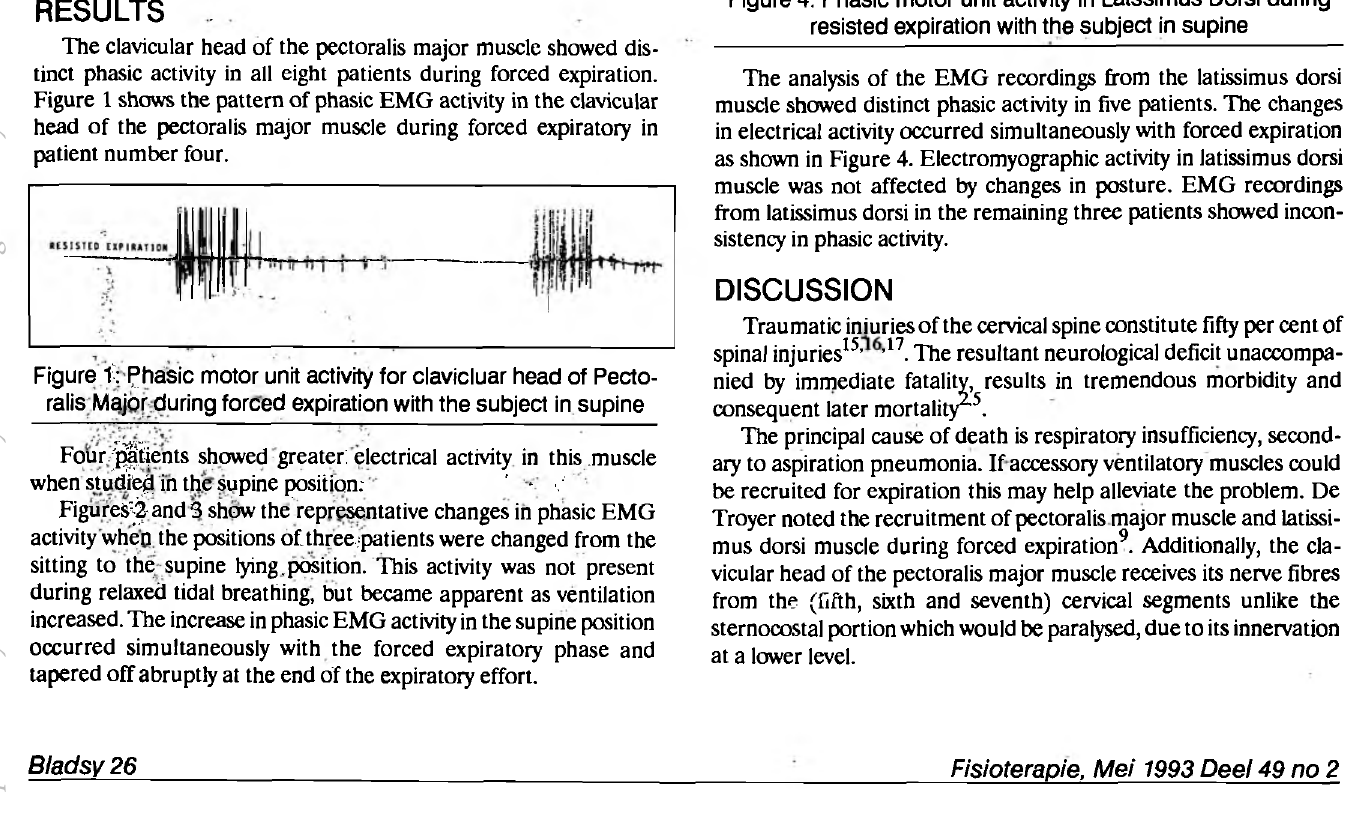
Figure 4: Phasic motor unit activity in Latssimus Dorsi during resisted expiration with the subject in